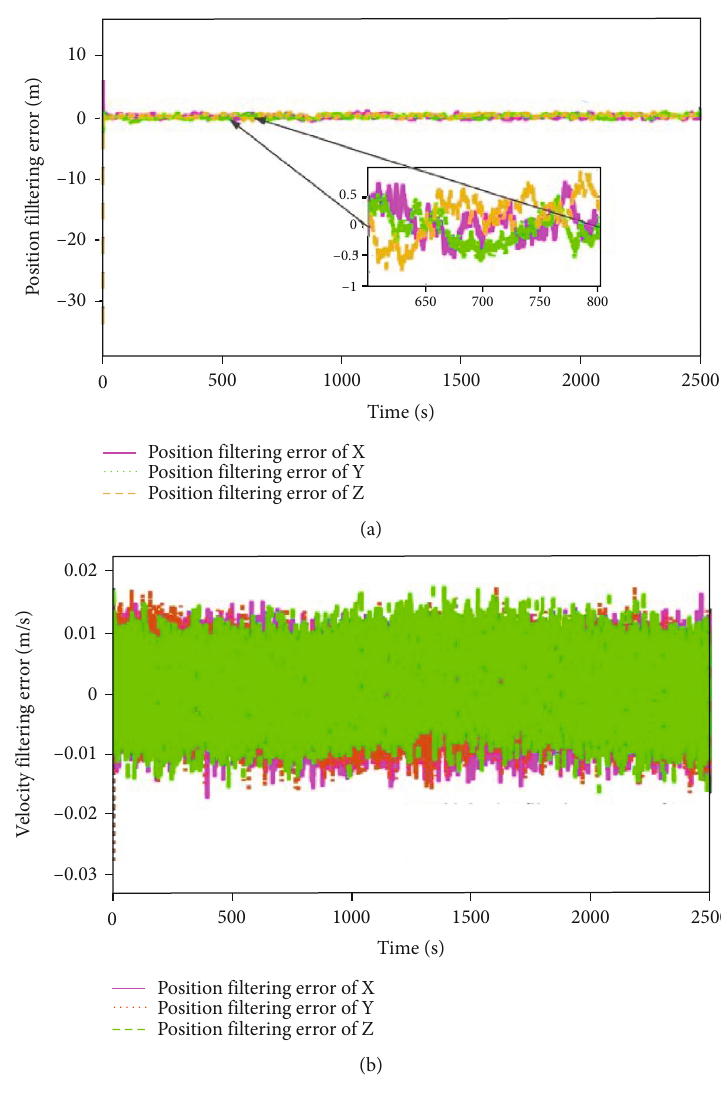
Figure 5: EKF algorithm e ff ect. (a) The position error. (b) The velocity